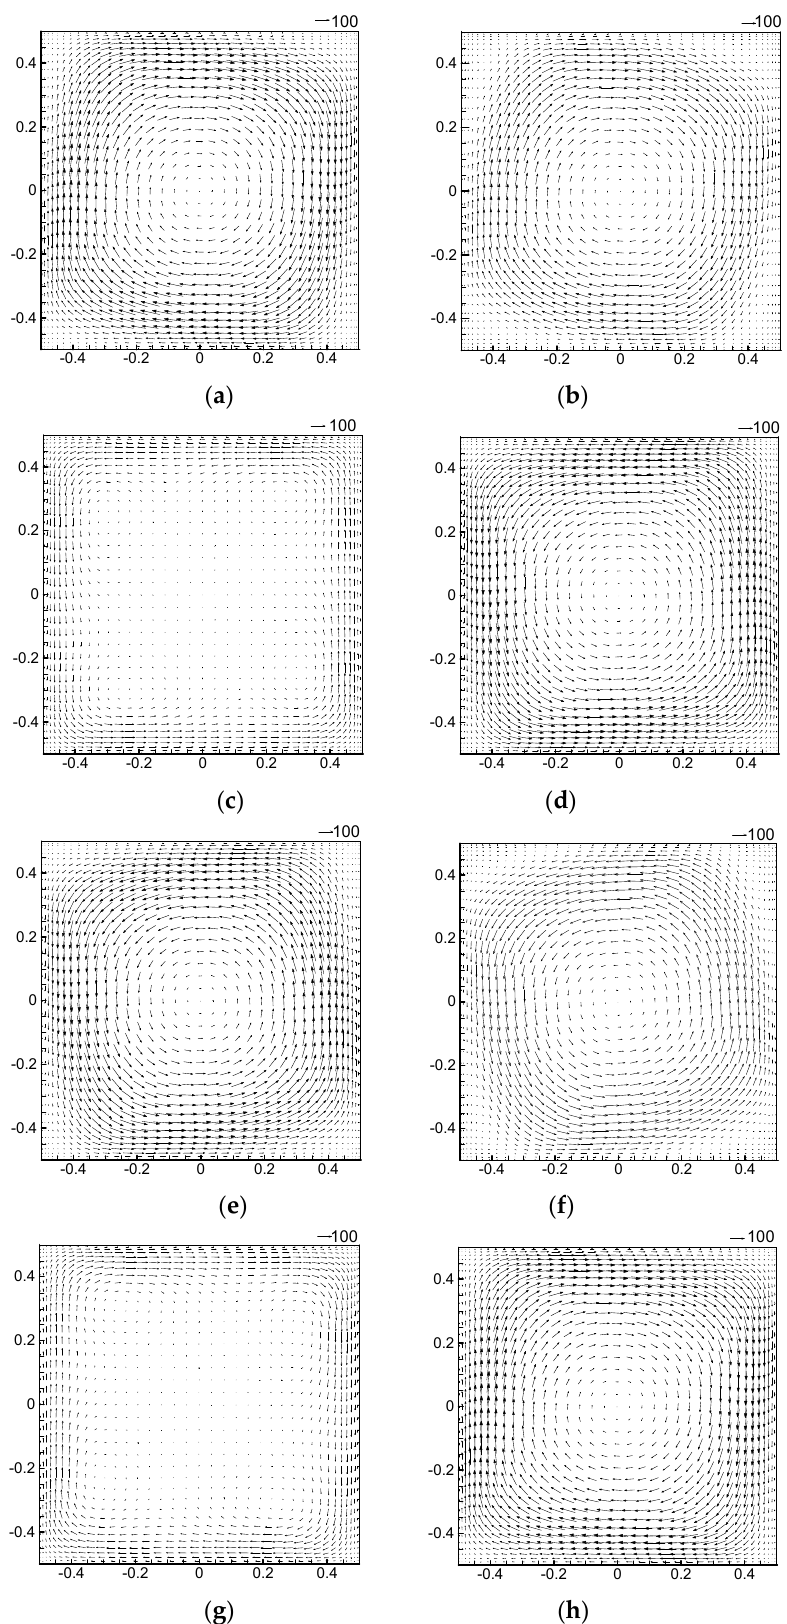
Figure 5. Velocity vector at x-o-y plane for Case 1: ( a ) ϕ = 0 (+) ; ( b ) ϕ = ϕ m /2 (+) ; ( c ) ϕ = ϕ m ; ( d ) ϕ = ϕ m /2 ( − ) ; ( e ) ϕ = 0 ( − ) ; ( f ) ϕ = − ϕ m /2 ( − ) ; ( g ) ϕ = − ϕ m ; ( h ) ϕ = − ϕ m /2 (+)